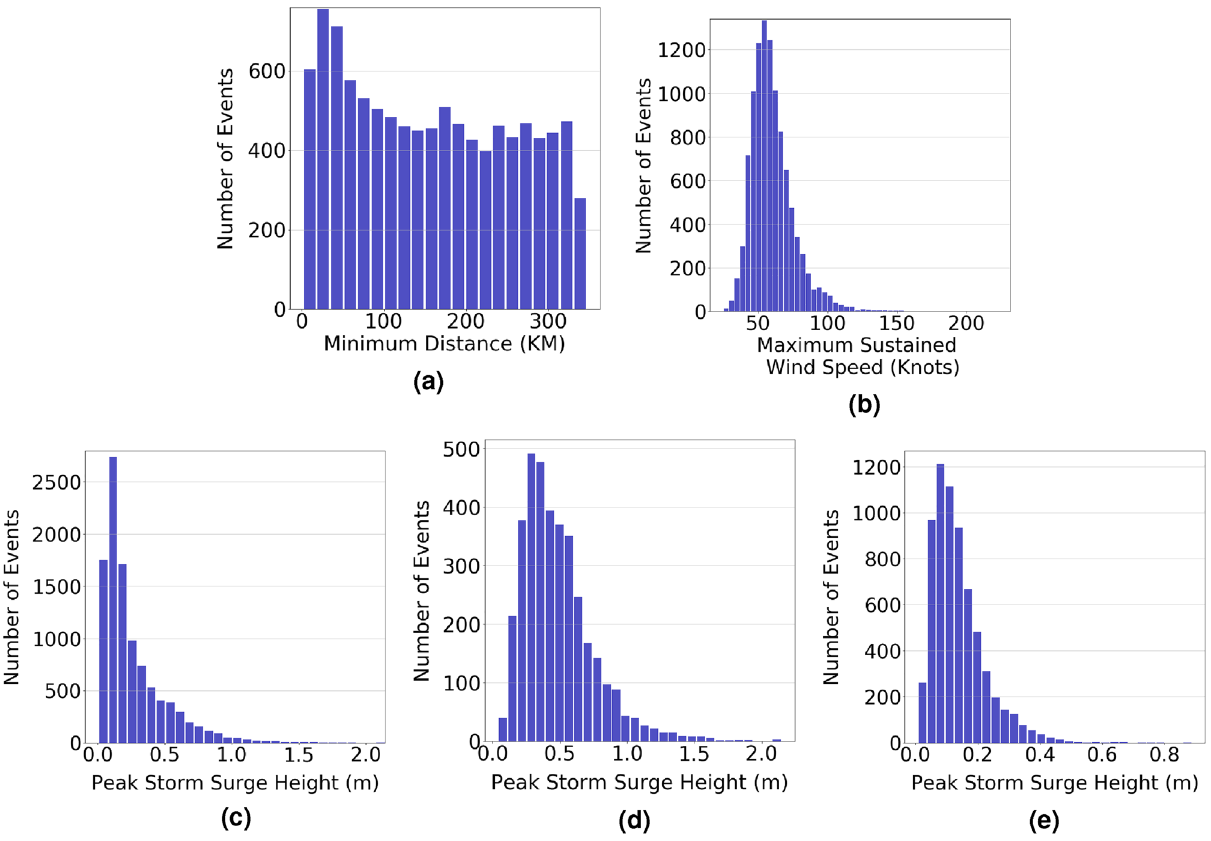
Figure 2. Histograms of the ( a ) minimum distance between TC eye and the study site, ( b ) sustained maximum wind speed when the TC is closest to the study site for the full data set, peak storm surge height for ( c ) the full data set, ( d ) TCs that pass within 100 km (DS-1), and ( e ) TCs that pass outside the 100 km region (DS-2). All histograms are for the Battery station.